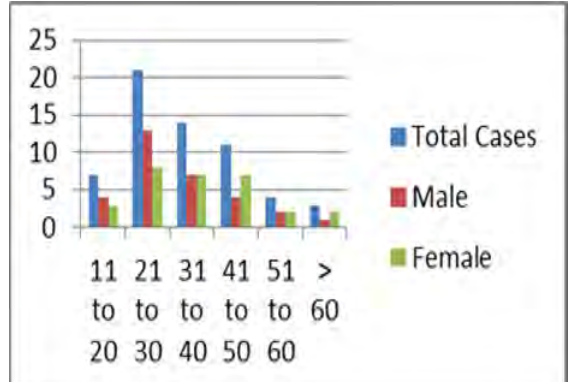
Fig. 1: Demographic distribution of Patients according to the age The mean duration of illness at diagnosis was 3.7 years and standard deviation of 4.87 IMAGE 2: Extent of disease At presentation Positive family history was seen in only 1.66% (n=1) and this was present in his first degree relative (sister). 10% (6) of the patients were current smoker